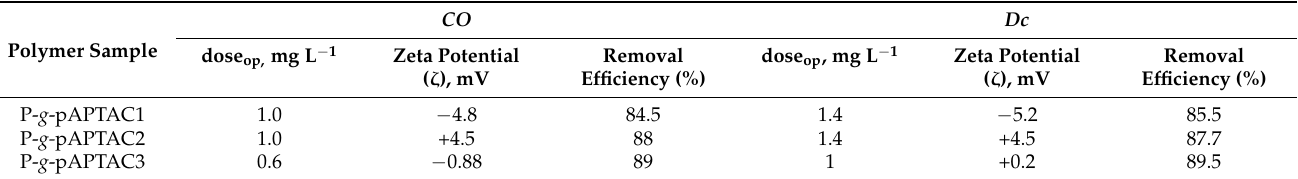
Figure 5. The residual CE absorbance (%) dependence on the polycation dose for P- g -pAPTAC2 (star), P- g -pAPTAC3 (circle); c CE (%, w / w )—0.03, settling time 1200 min. Table 3. Zeta potential ( ζ ) values corresponding to the polymer optimum dose (dose op